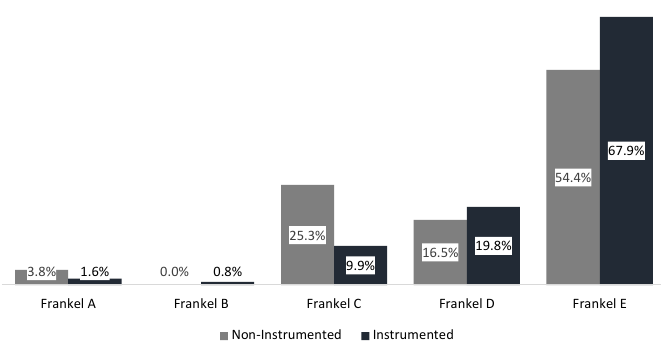
Figure 2. Frankel score at initial examination.